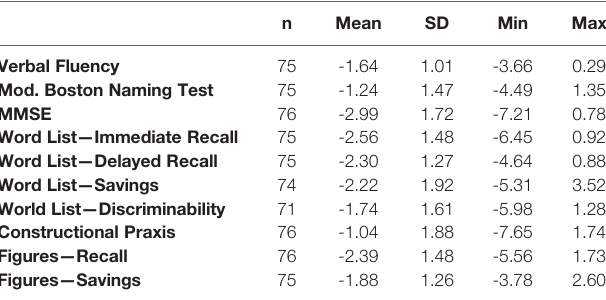
TABLE 1 | Z-scores of CERAD-NAB